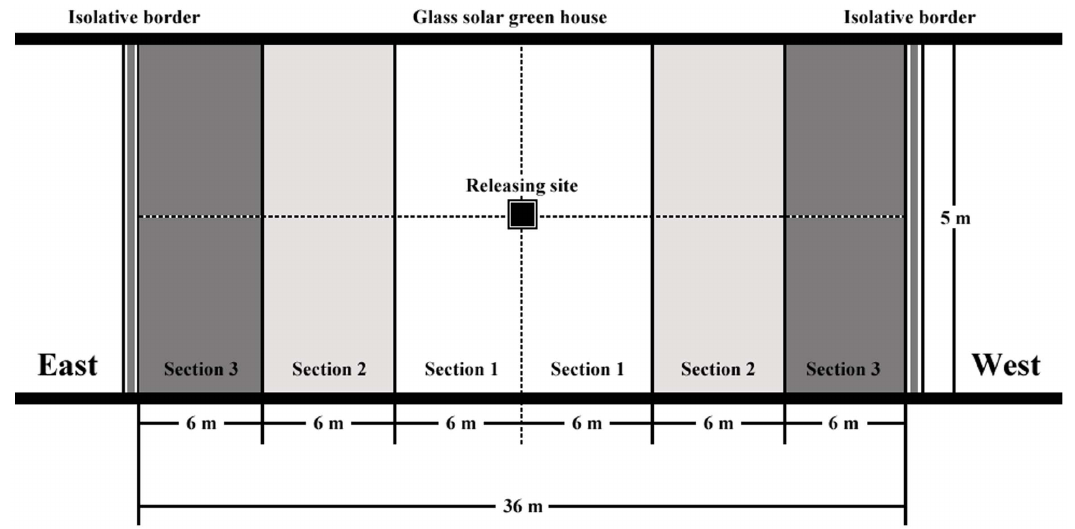
Figure 2. Observational sections in the field test of dispersal of populations of O. sauteri fed optimal ADMs.